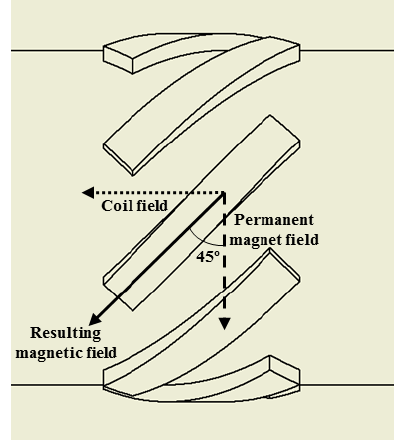
Figure 7. Resulting magnetic field on the strip.